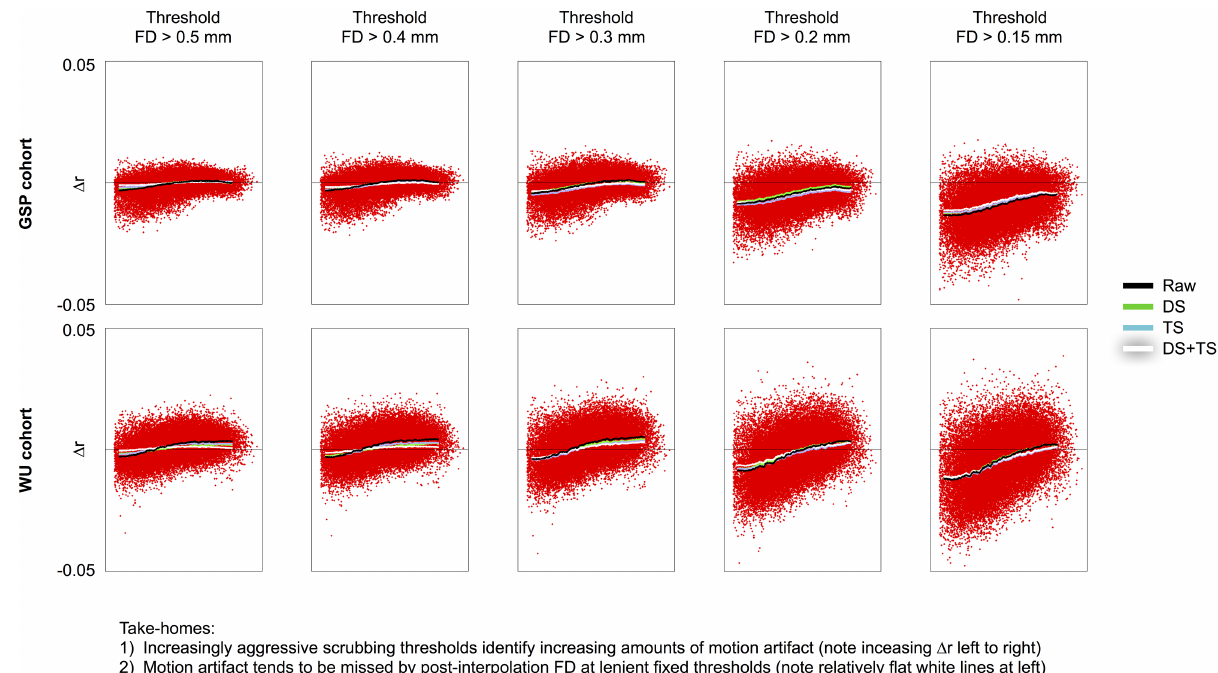
Fig 4. Volumes with motion are most easily identified in raw FD. For the GSP and WU cohorts, scrubbinganalysesin raw data are shown using severalversions of FD traces at several thresholds. Note that the slope of the red points increasesfrom left to right, indicating that greater amounts of distance-dependentartifact are being characterized at the thresholds approach the “floor values” of the FD trace. Similar data with the same effects are shown for all cohorts in S5 Fig and distributionsof each cohort’s FD under various preprocessing schemes are shown in S4 Fig. The x-axis represents distance, spanning 0–180